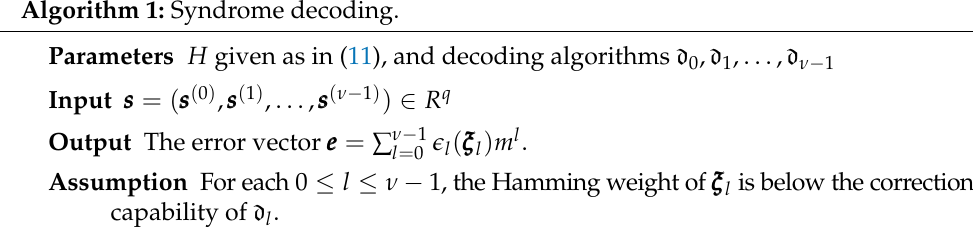
Algorithm 1: Syndrome